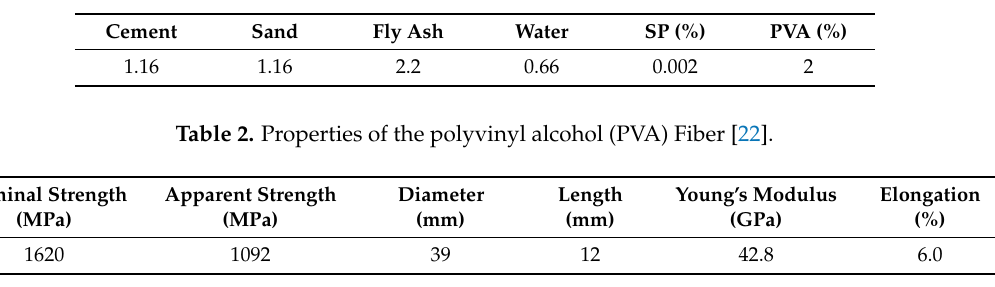
Table 1. Composition of polyvinyl alcohol fiber reinforced engineering cementitious composite